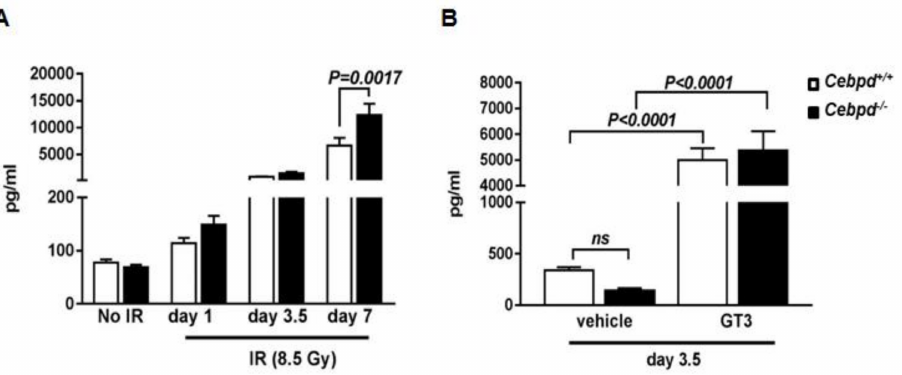
Figure 6. G-CSF induction by IR and combination of IR and GT3 is independent of Cebpd . ( A ) Plasma levels of G-CSF in Cebpd +/+ and Cebpd − / − mice at the indicated time points post-8.5